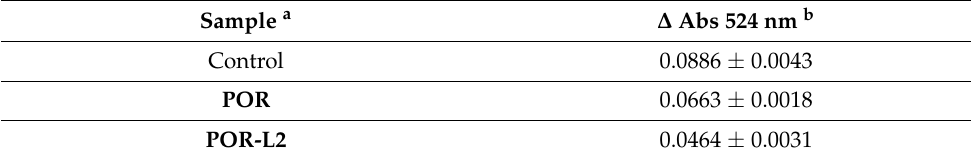
Table 3. Observed absorbance changes obtained for the tested